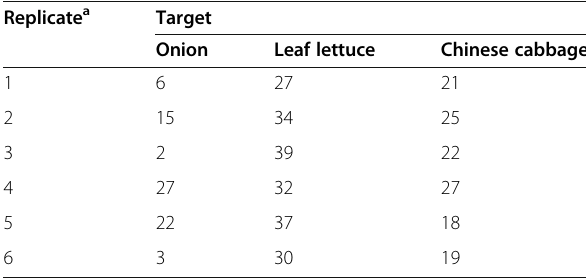
Table 1 The number of cells with GFP signals obtained from the gene transfer with TSGAMAP Replicate a